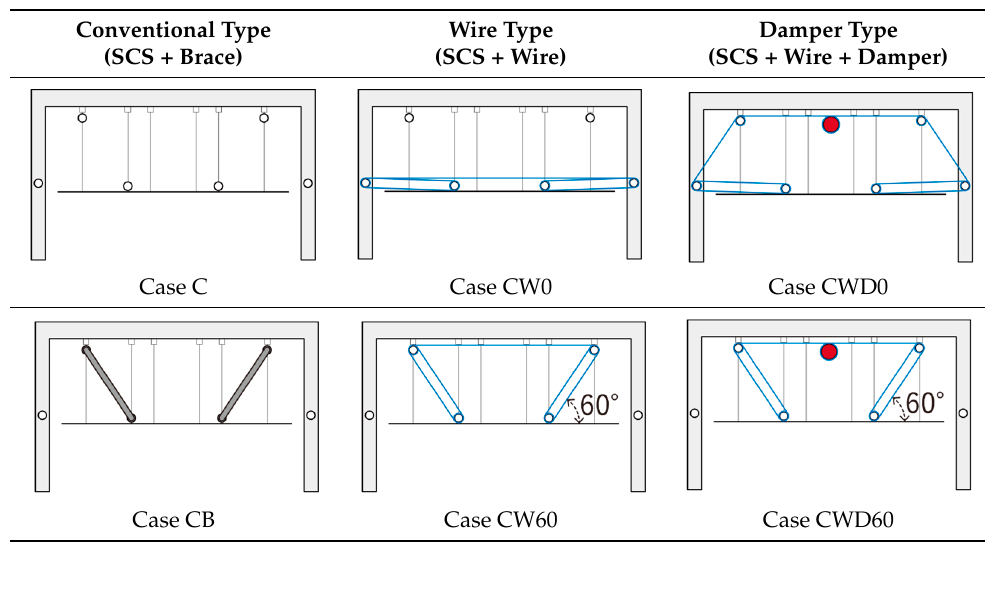
the proposed damper in Section 3.1. Moreover, to investigate the influence of the wire